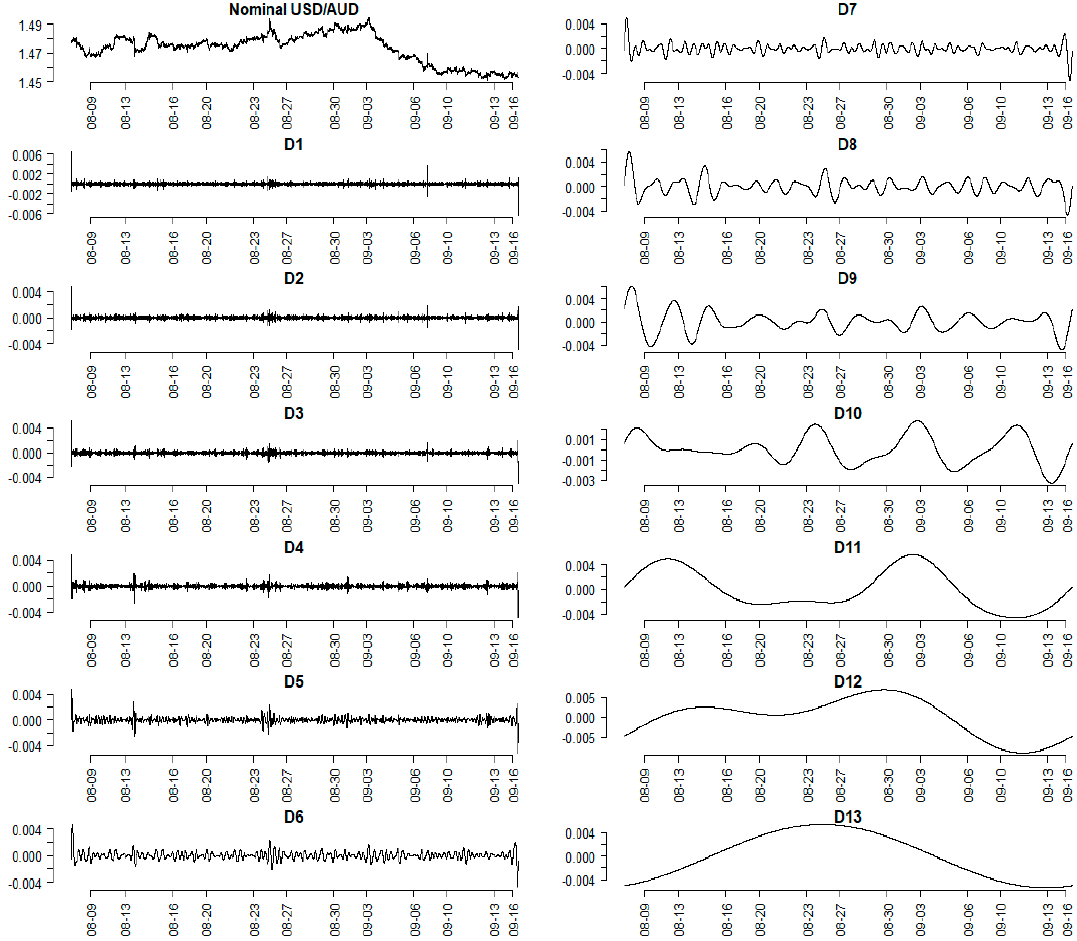
Figure 2. Multi-resolution plots of USD/AUD time series. Notes: This figure presents the MRA for the full data range from 7th August 2019, to 9:25, 16th September 2019. In each panel, the horizontal axis indicates the corresponding days of the two months.